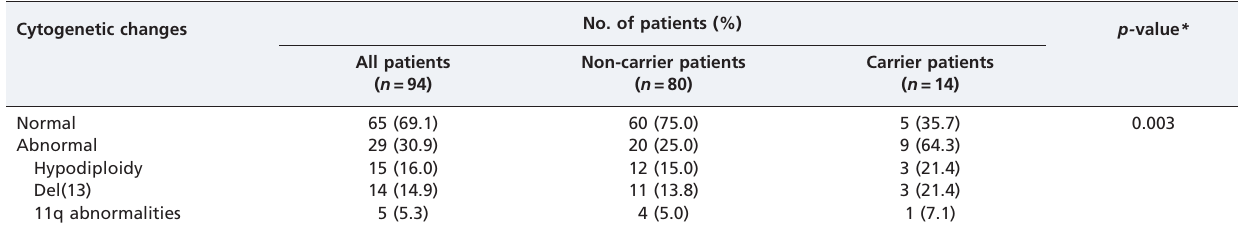
Table 2 - Cytogenetic abnormalities detected by conventional cytogenetic analysis in 94 myeloma patients. Cytogenetic changes